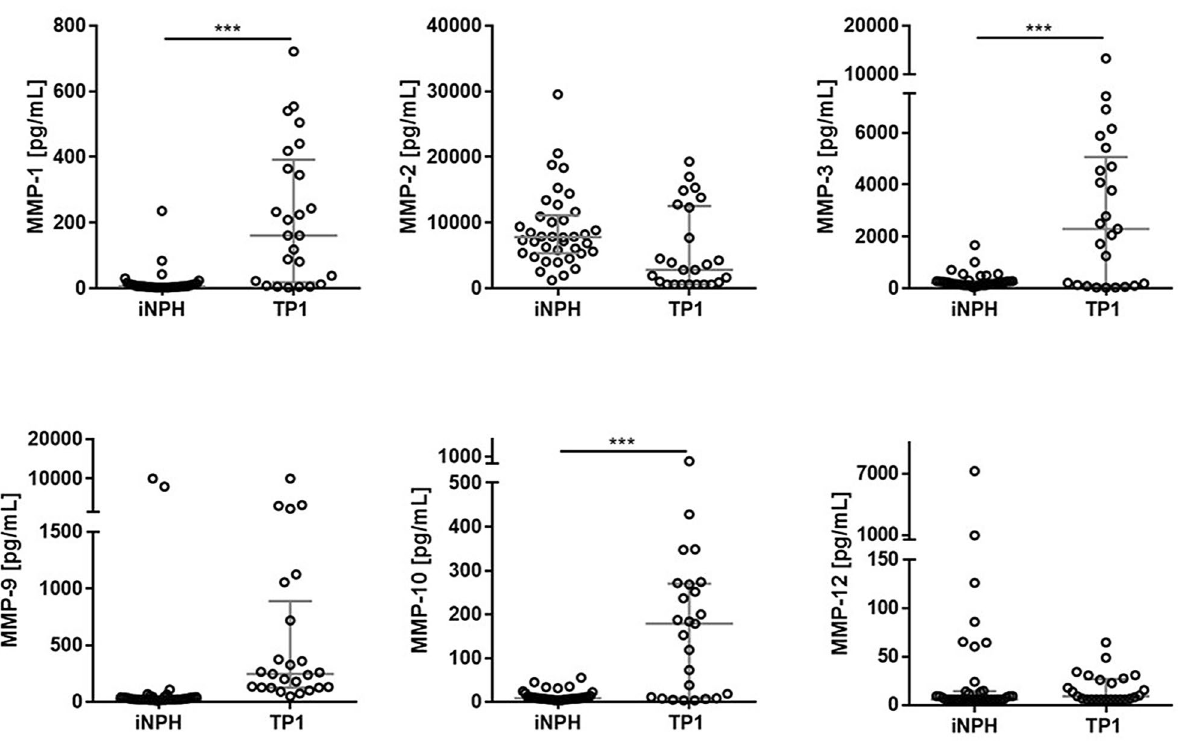
Figure 1. CSF concentrations for the measured MMPs for the iNPH and TBI groups. The horizontal lines represent the median and interquartile ranges. Statistical significance in CSF MMP concentrations between TBI group (time point 1; TP 1) and contrast (iNPH) group: ***p < 0.001. Analysis of covariance was used to examine the differences between the groups, accounting for the effect of age. N (number of patients): n = 38 for iNPH, n = 25 for TBI